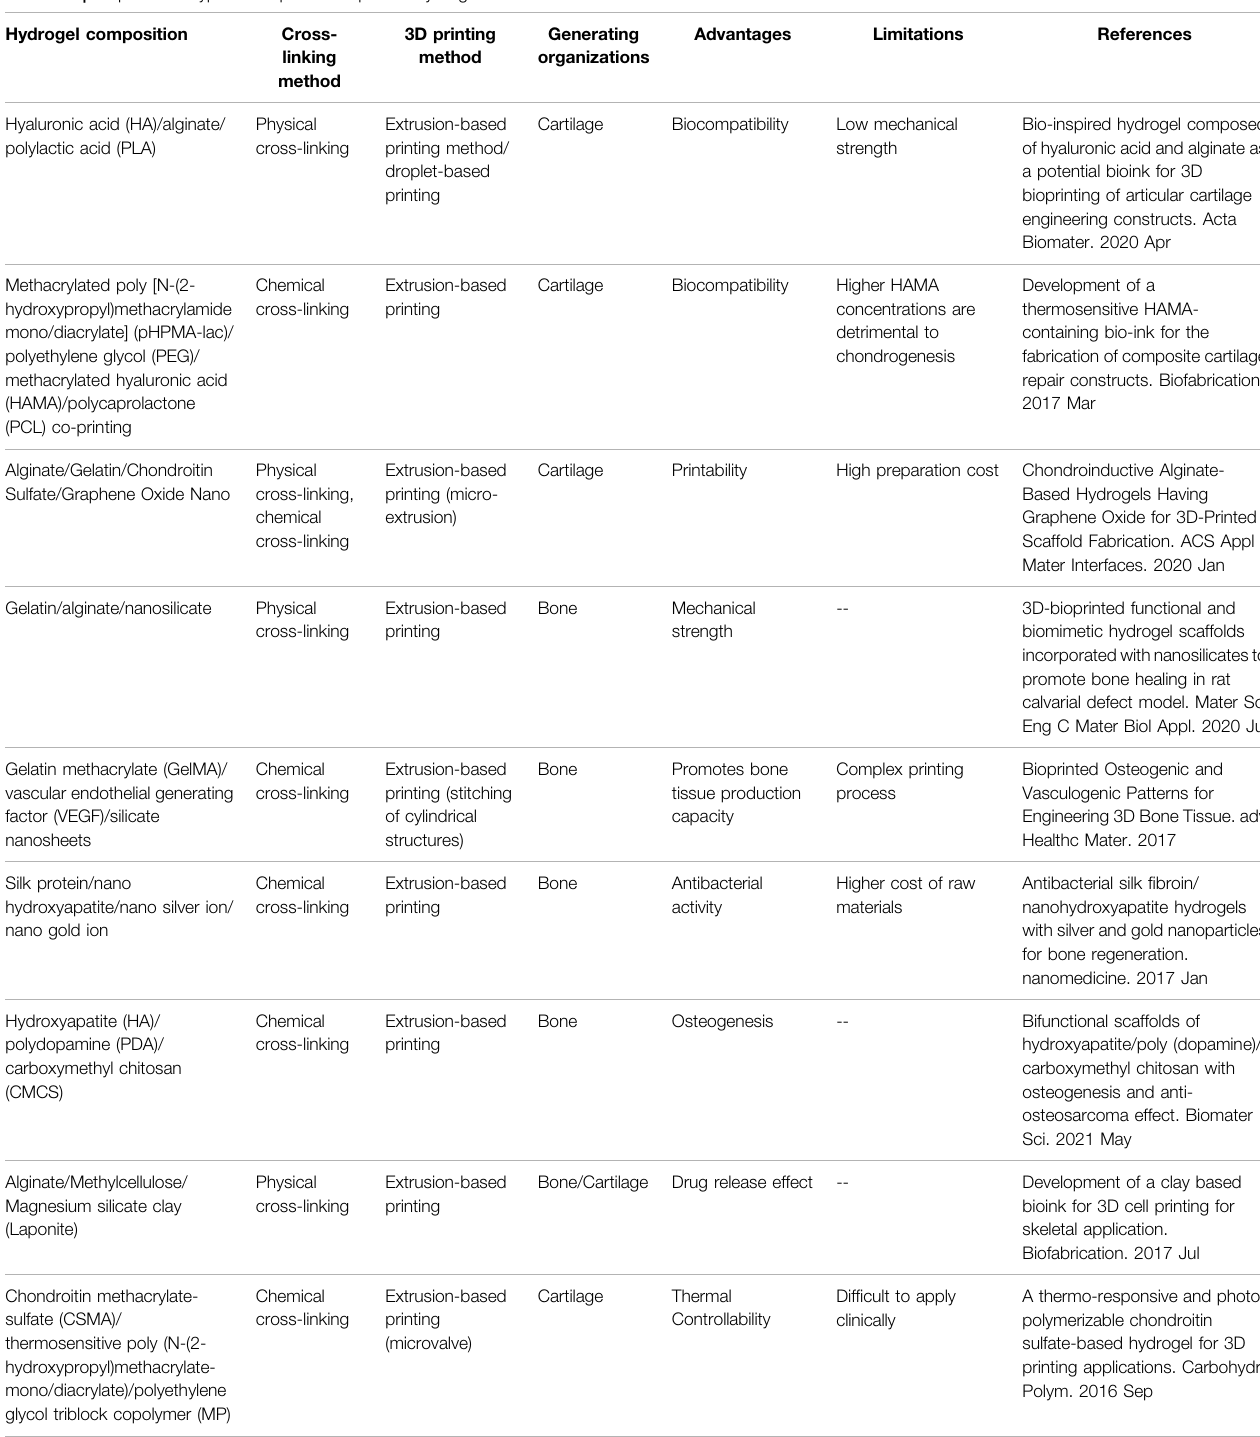
TABLE 1 | Properties of typical composite 3D-printed